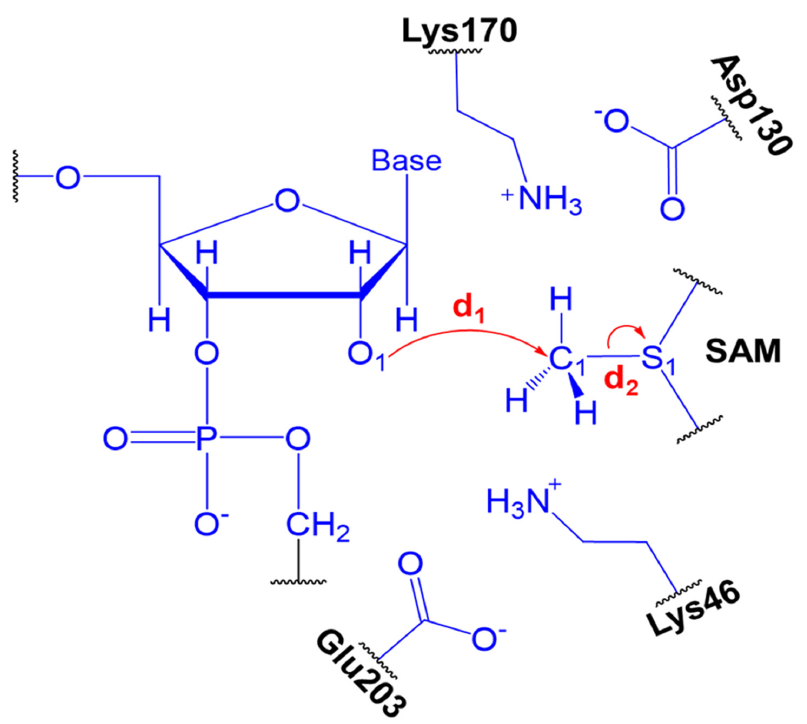
Figure 8. The QM region and reaction coordinate used for QM/MM simulations. This schematic representation involves the ribose of the base, SAM, and the side chain of Glu203, Lys46, Asp130, and Lys170 residues of the active site of the nsp16 protein. The position of the quantum link atoms is indicated as black dots. The atomic coordinates of the QM atoms for TS are included in ESI file. Note that all atoms of SAM were included in QM region during QM/MM